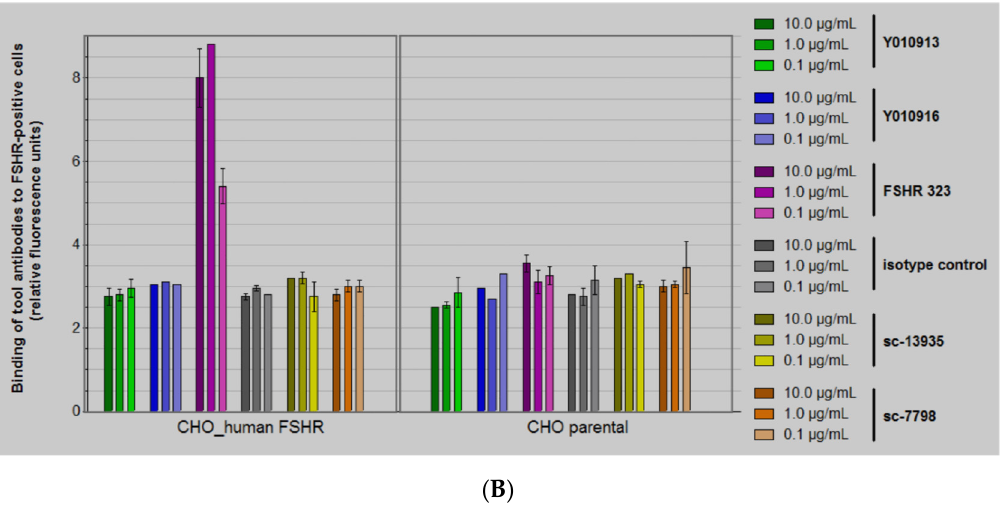
Figure 2. Binding of tool antibodies to cells expressing the recombinant human FSHR. Fluorescence ‐ activated cell sorting (FACS) analysis using Flp ‐ In CHO/hFSHR in comparison to the parental Flp ‐ In CHO cells as specificity control. Different antibodies were tested for binding to cells overexpressing human FSHR versus parental cells not expressing human FSHR. Three antibody concentrations were tested ( A ); Antibody binding to cells was tested after fixation (formaldehyde treatment over ‐ night) ( B ).